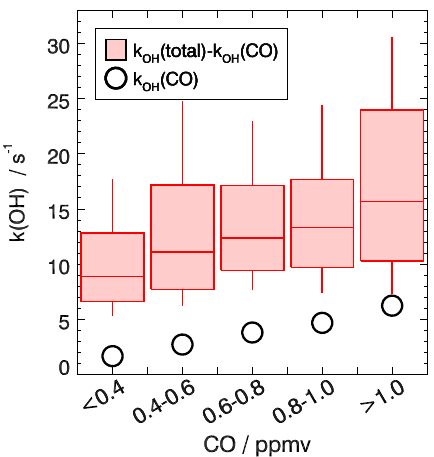
Figure 3. Correlation between OH reactivity excluding CO and CO mixing ratios. Red boxes give 25 and 75 percentiles, and whiskers give 10 and 90 percentiles of the k OH distribution. Black circles show median values of OH reactivity that is caused by